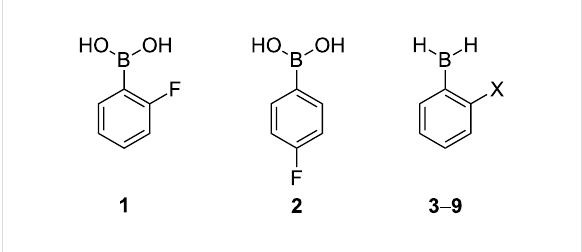
Figure 1: 2- and 4-fluorophenylboronic acids ( 1 and 2 ) and 2-substi- tuted phenylboranes [X = F ( 3 ), Cl ( 4 ), Br ( 5 ), OH ( 6 ), SH ( 7 ), NH 2 ( 8 ) and PH 2 ( 9